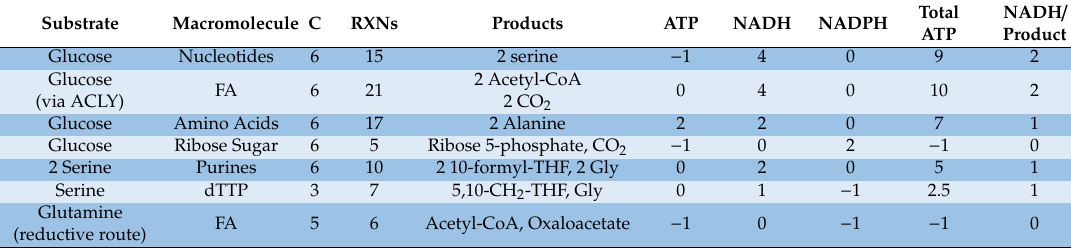
Table 2. ATP and co-factors produced from glucose, serine, and glutamine when biosynthesis is the main metabolic constraint. Metabolism of glucose can downstream contribute to the synthesis of nucleotides, fatty acids, amino acids and ribose-5-phosphate through the utilisation of its carbon atoms within specific pathways. One-carbon cycle is utilised to free one-carbon units from serine to generate purines and dTTP. Glutamine can anaplerotically support the TCA cycle and generate cytosolic citrate through reductive carboxylation which subsequently feeds into fatty acid synthesis. NADH generated per product is shown here to indicate the burden of NADH during anabolic state [60]. 3PG, 3-phosphoglycerate; Gly, glycine; FA, fatty acids; THF, tetrahydrofolate; 5,10-CH 2 -THF, 5,10-methylene-tetrahydrofolate; dTTP, deoxythymdine triphosphate; RXN, reaction; C, carbons per substrate molecule.